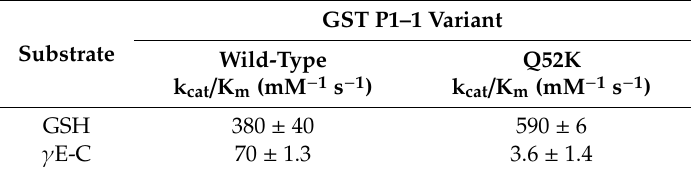
Table 4. Catalytic e ffi ciency (k cat / K m ) of GST P1–1 variants with alternative thiol